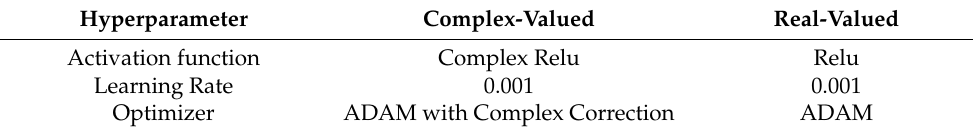
Table 4. Table of hyperparameters used for the complex/real-valued convolution networks.